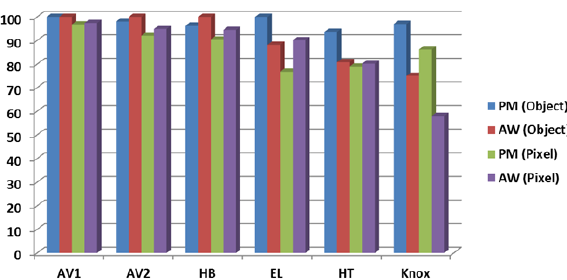
Figure 10: Object and area-based correctness comparison of building detection process. PM (object) and PM (pixel) represent the object and pixel-based completeness of the proposed method. AW (object) and AW (pixel) correspond to the same for Awrang- jeb’s method. The X-axis labeling represents the data sets.